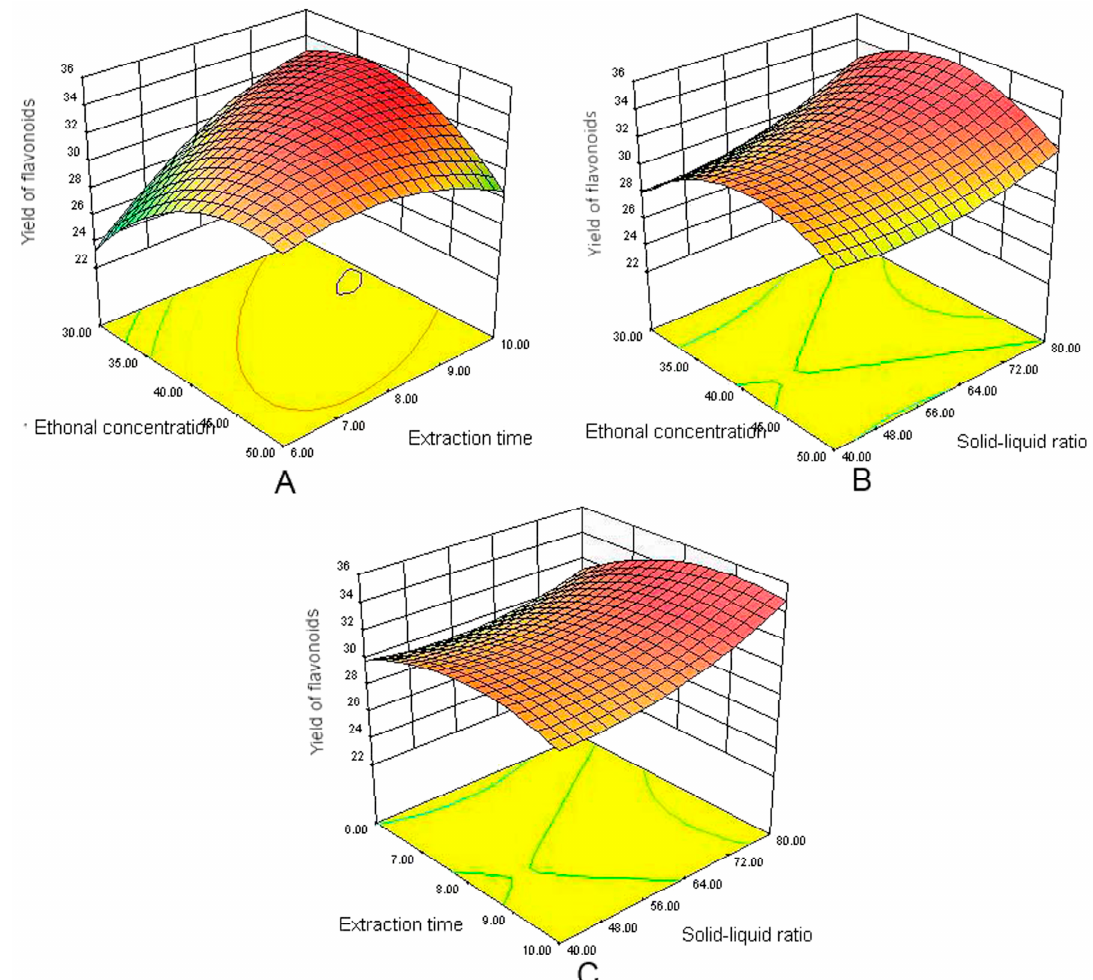
Figure 2. ( A ) Response surface graph showing interaction between ethanol concentration (%) and extraction time (min); ( B ) response surface graph showing interaction between ethanol concentration (%) and solid-liquid ratio; and ( C ) response surface graph showing the interaction between extraction time (min) and solid-liquid ratio (g/mL).